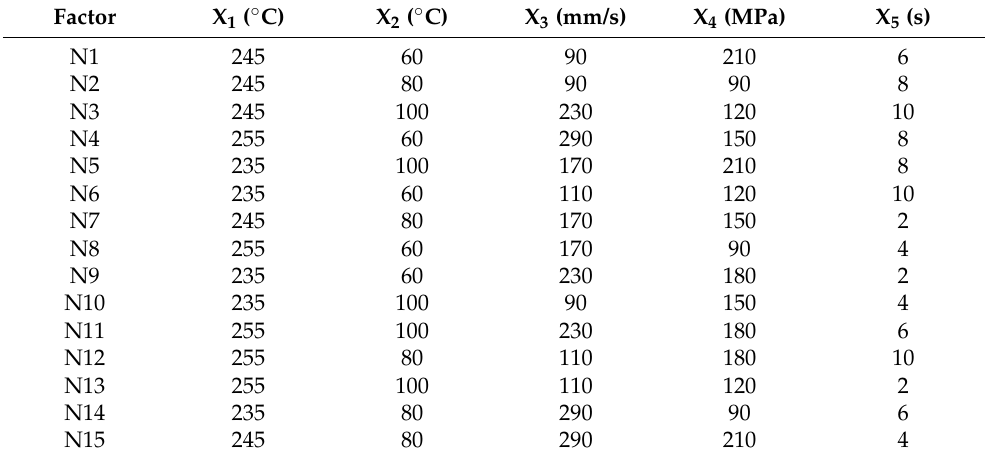
Table 3. U 15 (3 2 × 5 3 ) mixed level uniform